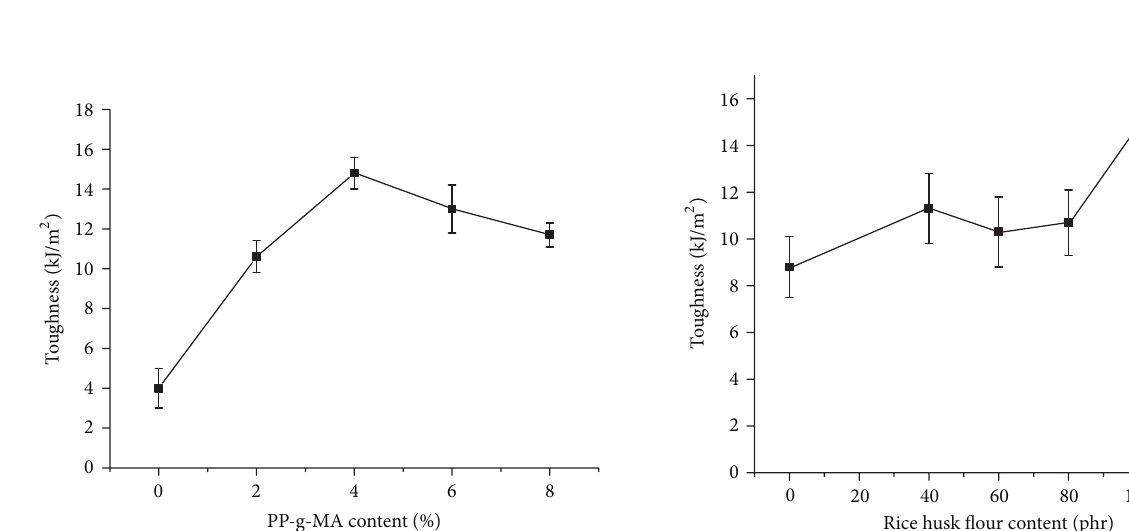
Figure 7: Effect of RHF content on toughness of PP/RHF compos- ites in the presence of 4wt%